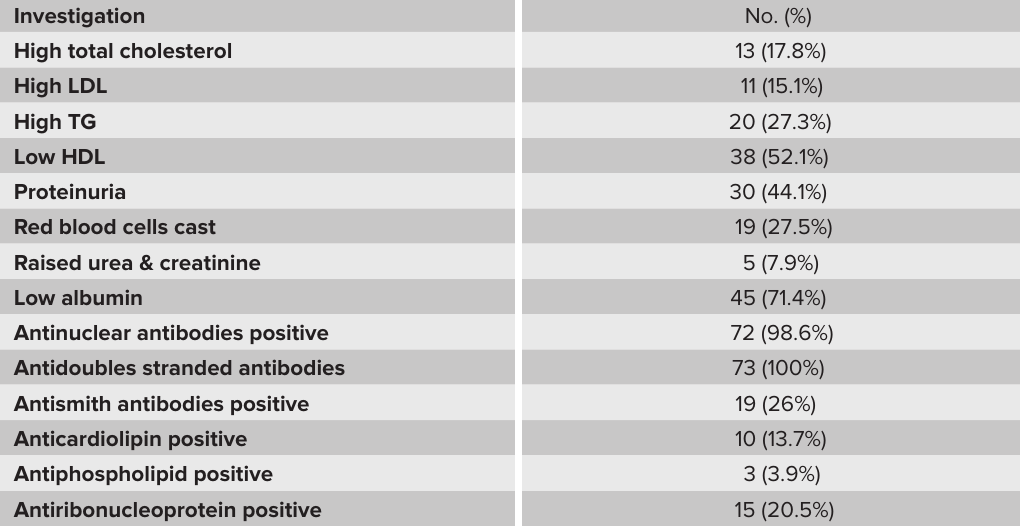
Table 2: Laboratory Investigations of SLE